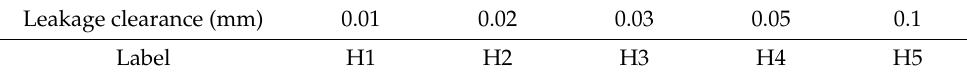
Table 4. Leakage clearance of reversing valve.